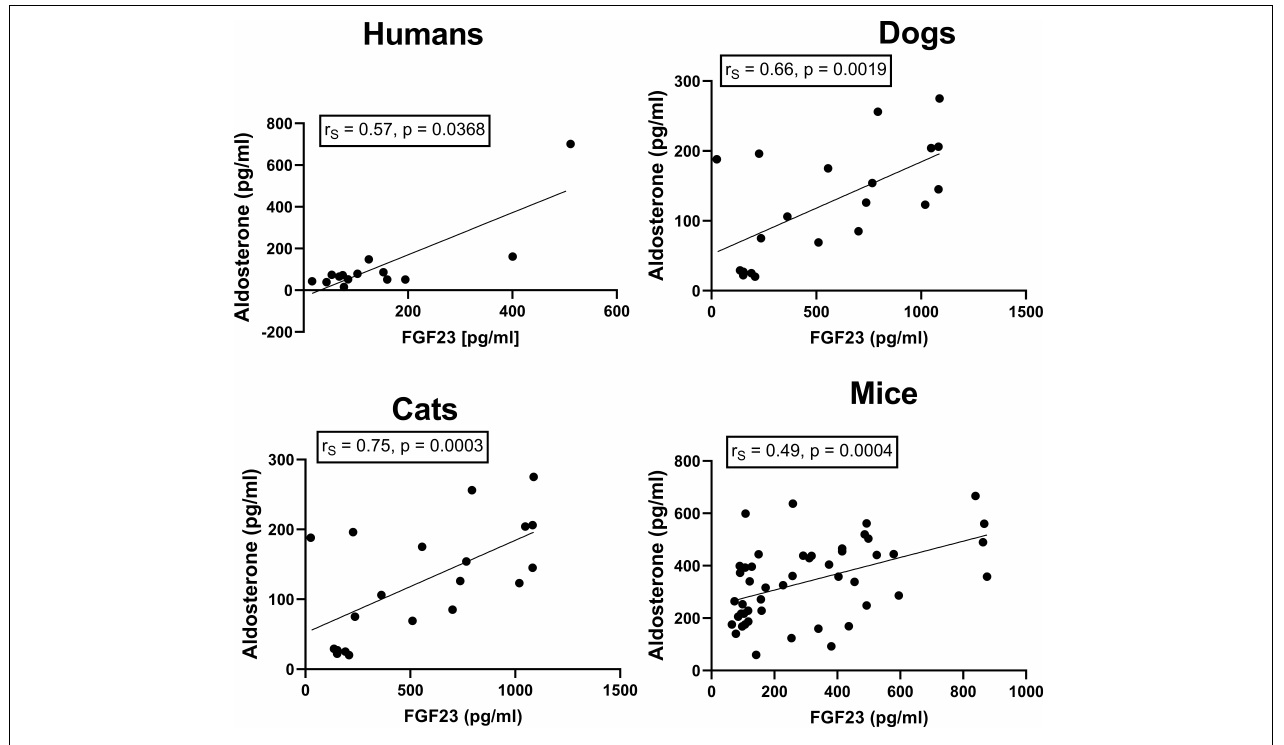
FIGURE 3 | Association between circulating FGF23 with serum aldosterone in human, feline, and canine CKD patients as well as in experimental murine CKD. Serum intact FGF23 and aldosterone levels are positively correlated in humans ( n = 14), dogs ( n = 20), and cats ( n = 18) with CKD, as well as in mice with experimentally induced CKD ( n = 48). Insets show Spearman rank correlation